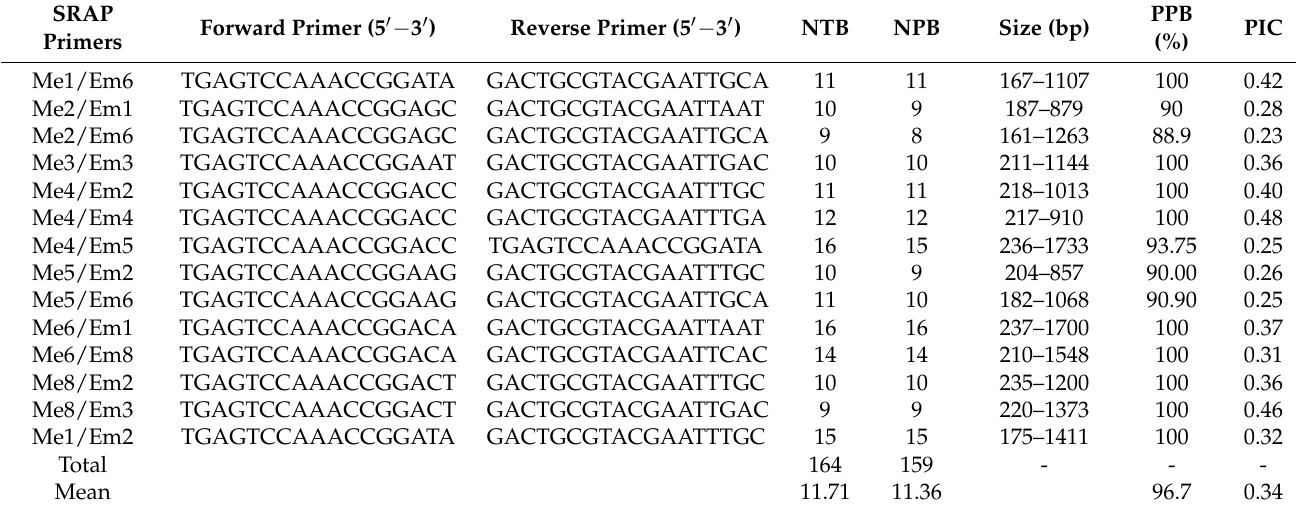
Table 2. SRAP primer sequences and analysis of the generated banding patterns of A. exscapus subsp. transsilvanicus .